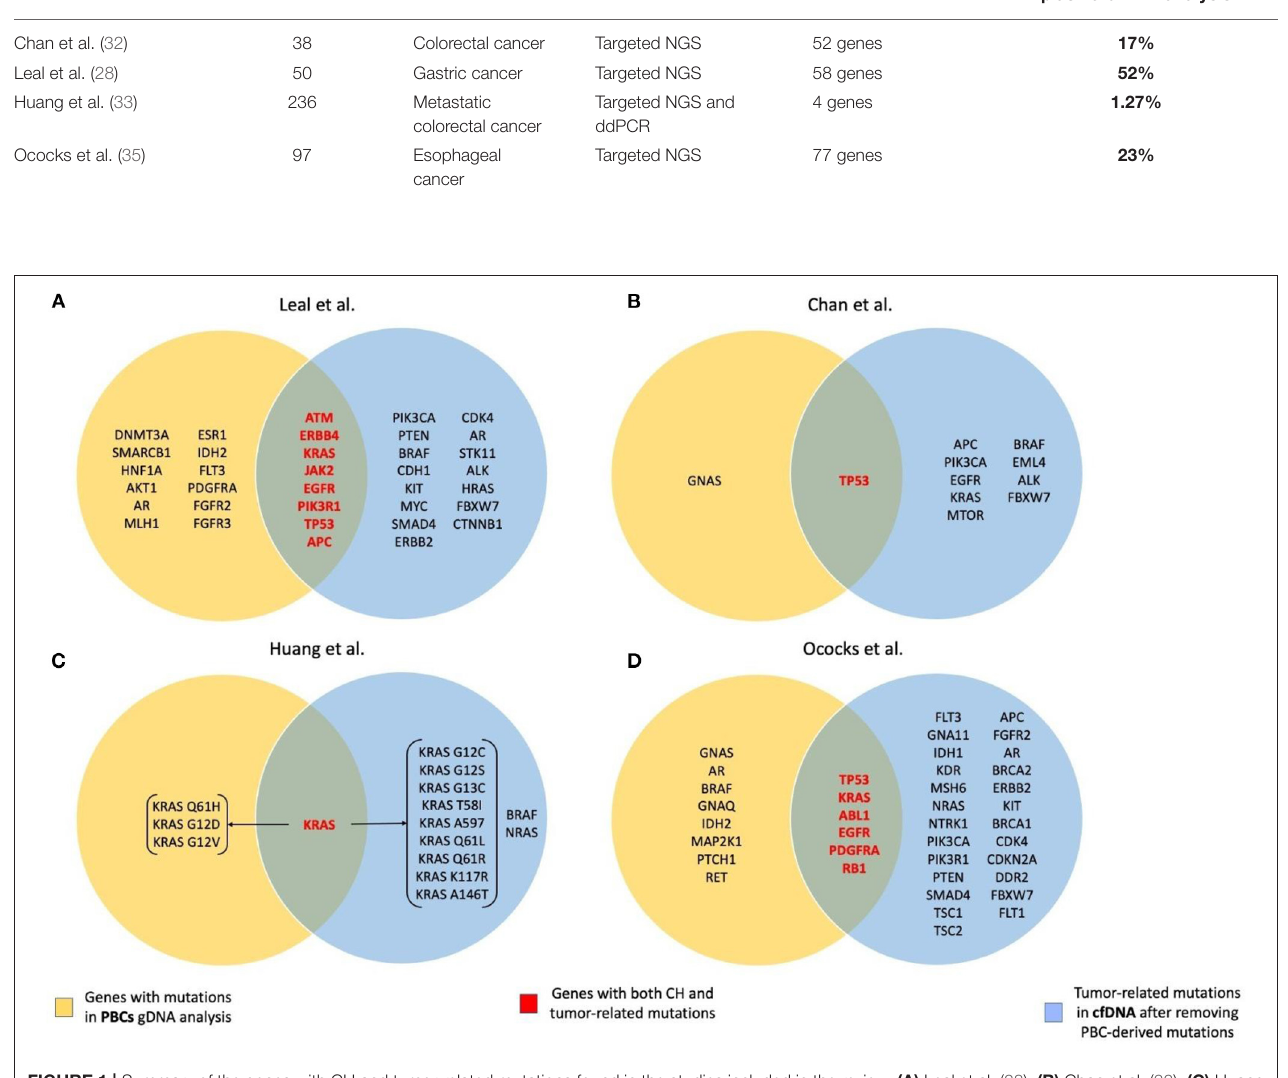
FIGURE 1 | Summary of the genes with CH and tumor-related mutations found in the studies included in the review. (A) Leal et al. (28); (B) Chan et al. (32); (C) Huang et al. (33); (D) Ococks et al. (35).